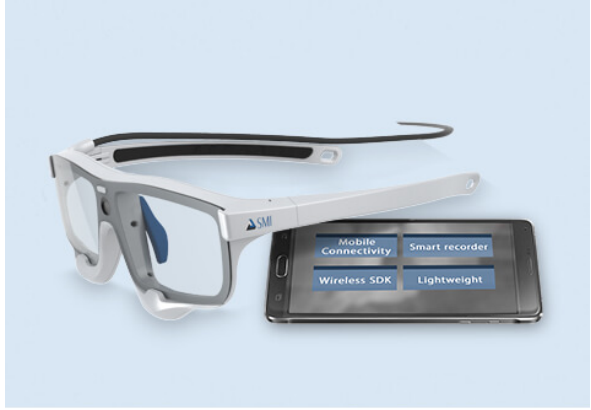
Figure 3: SMI eye-tracking glasses and mobile device (Source: hmi-